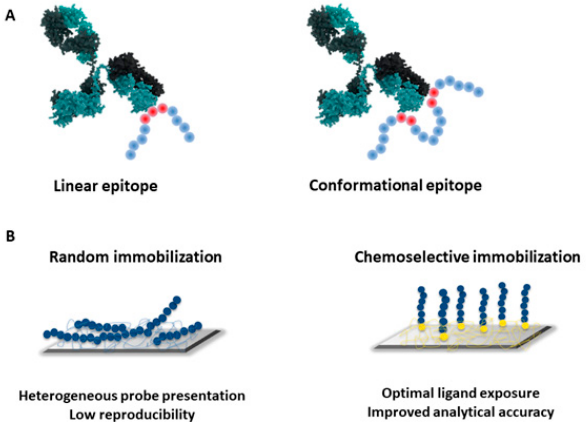
Figure 2. ( A ) Schematic illustration of linear vs. discontinuous epitopes; ( B ) random immobilization strategies may result in non-homogeneous probes presentation to the target antibodies, mining the